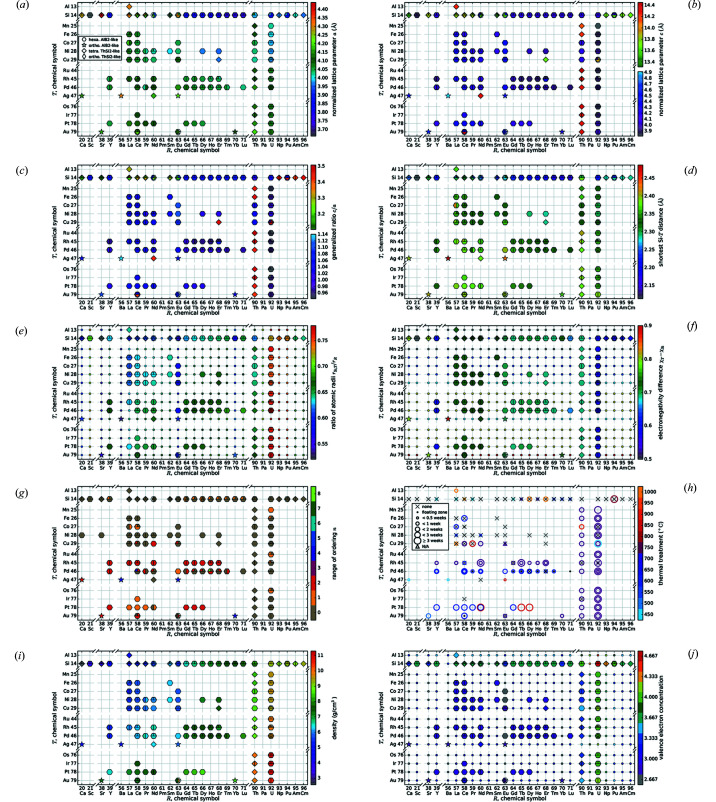

R–T diagram of the RSi2 and R
2
TSi3 compounds. (a) normalized lattice parameter a, (b) normalized lattice parameter c, (c) normalized ratio c/a of lattice parameters, (d) shortest Si—T bonds, (e) ratio of atomi radii r
T,Si/rR, (f) electronegativity difference EN(Si,R), (g) range of ordering, (h) thermal treatment, (i) density and (j) valence electron concentration. The used markers symbolize the crystal system: hexagon — hexagonal AlB2-like systems, open star — orthorhombic, AlB2-like systems, diamond — tetragonal ThSi2 systems, elongated diamond — orthorhombic GdSi2 systems. The lattice parameters a and c of the subplots (a) and (b) are normalized to the R–R distances within a/b and along c, respectively, to provide comparability. Accordingly, the ratio c/a in subplot (c) is also based on these normalizations. The shortest Si/T bonds in subplot (d) are calculated based on the formula (1). Subplot (e) depicts the ratio of atomic radii q
rad, which is based on equation (2). Subplot (f) shows the electronegativity difference for the evaluation of the Zintl conditions. For the range of ordering n in subplot (g), a structure with disordered Si/T sites is marked with a black symbol, otherwise the color stands for the range of ordering n. For the thermal treatment (h), the color represents the temperature and the circle size the time of the treatment (triangle if unknown). Application of the floating zone method is marked with a black dot •, while no treatment is marked with a cross ×. The plots for the theoretical properties vec and ratio of radii were completed for not experimentally determined compounds (small circles) (Riedel & Janiak, 2011 ▸).